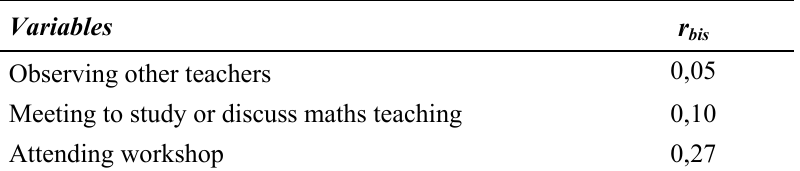
Table 7 : Correlations between students’ achievement in mathematics